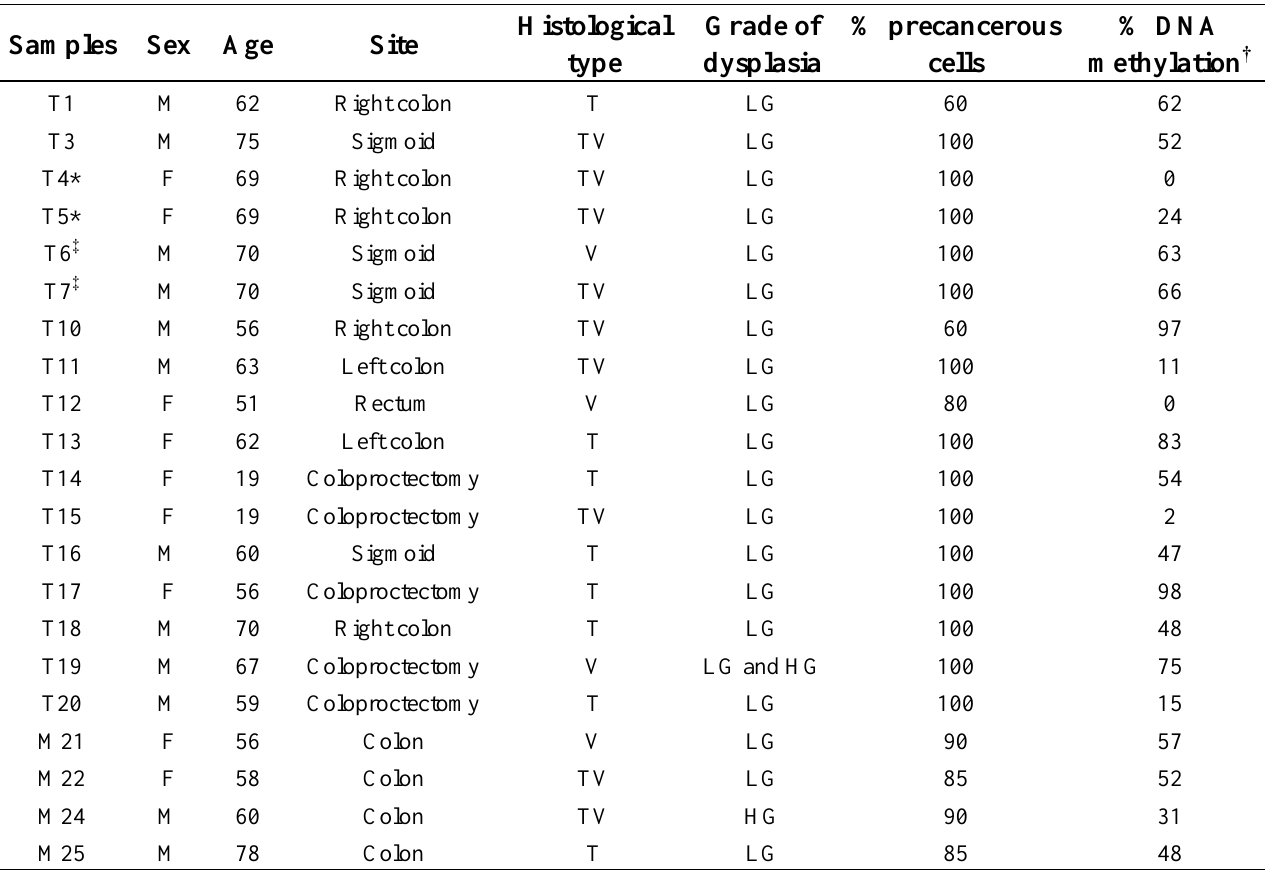
Table 1. Clinical features of the analyzed